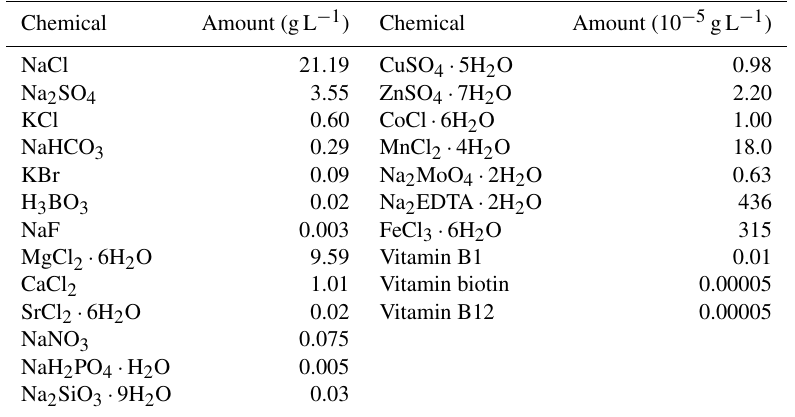
Table 1. Composition of the artificial seawater (modified F/2 media, final pH was adjust to 8). Regents were purchased from Sinopharm and